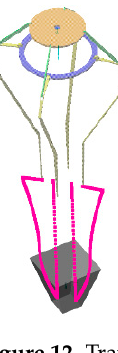
Table 4. Table of motion equations.